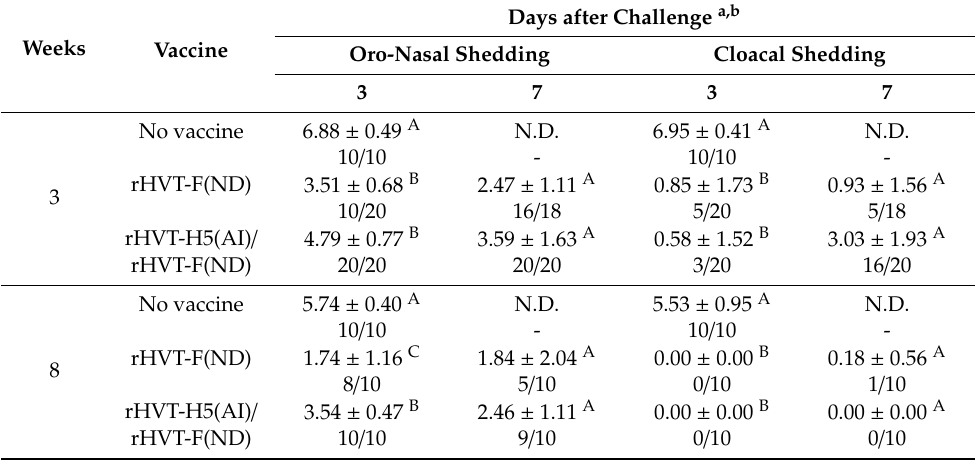
Table 3. Oro-nasal and cloacal shedding of vNDV after challenges at 3 weeks and 8 weeks of age with vNDV to SPF WL chickens (experiment I) vaccinated at day-old with rHVT-F(ND), rHVT-H5(AI), or both vaccines.